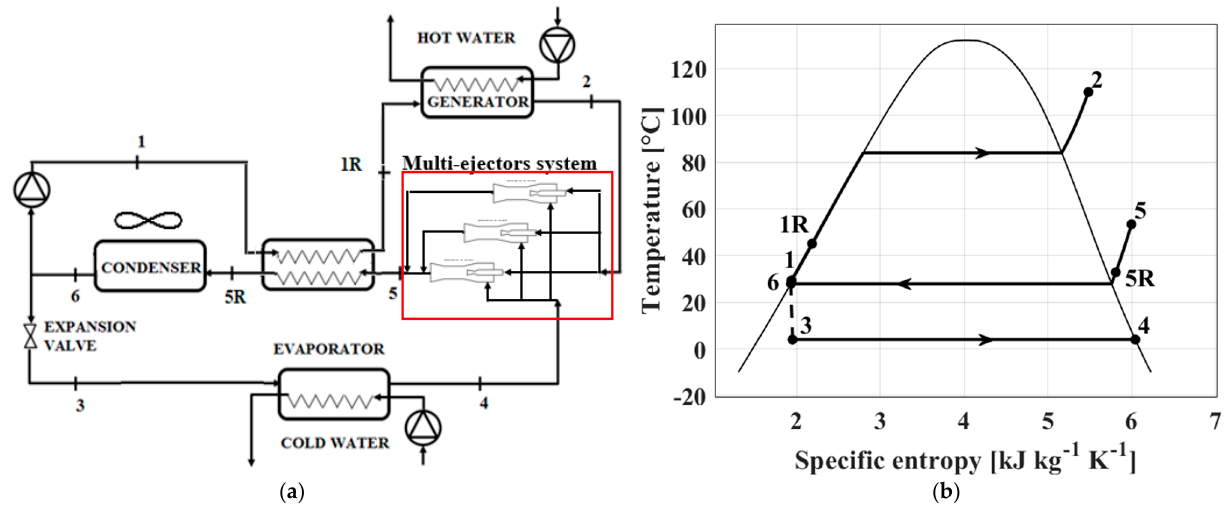
Figure 2. ( a ) Schematic lay-out of the hybrid ejector cycle proposed in this analysis; ( b ) Example of an ejector cooling cycle on T-s diagram for the fluid R717.